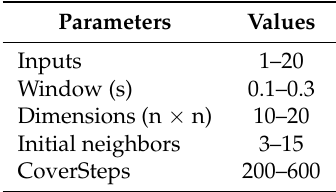
Table 5. Range of SOM configuration